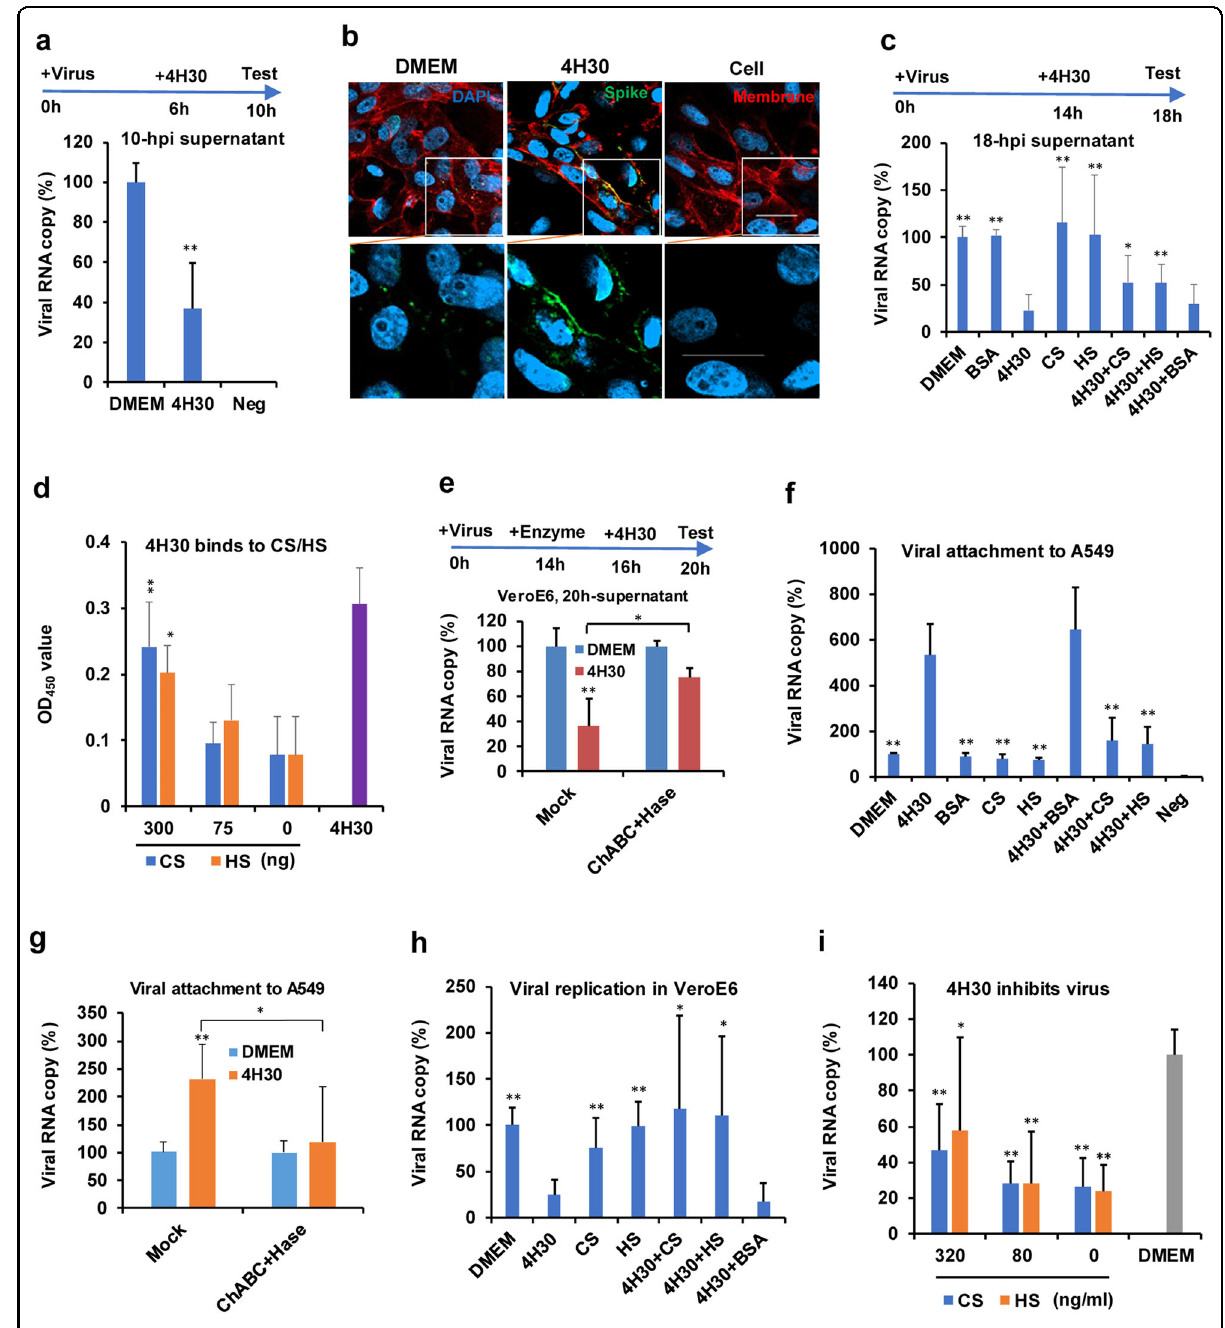
Fig. 3 (See legend on next